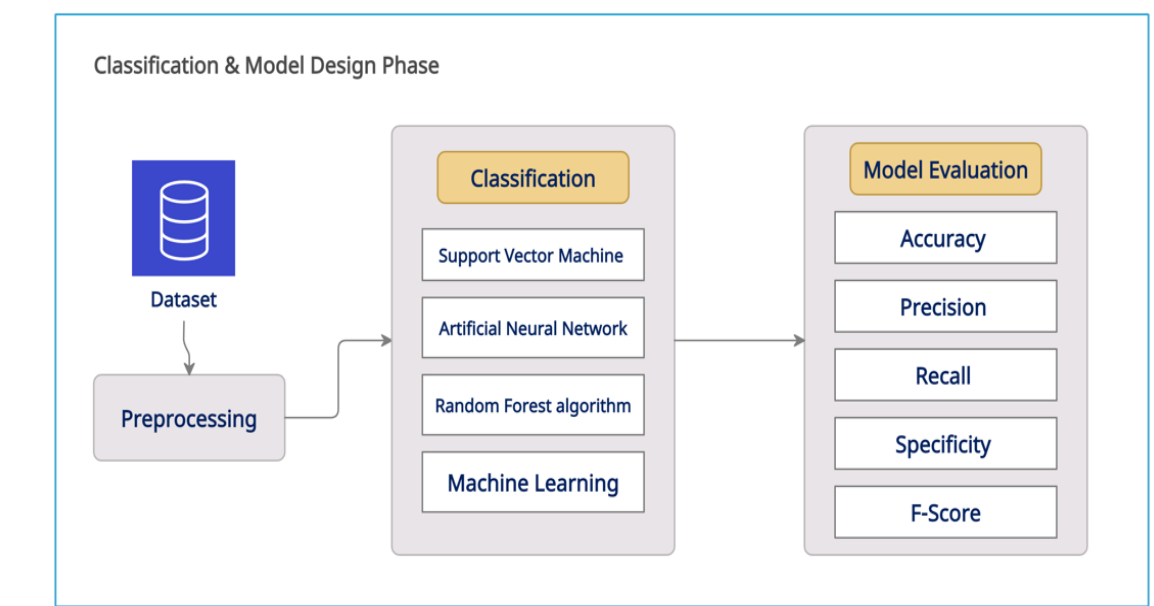
Figure 1. Proposed methodology.